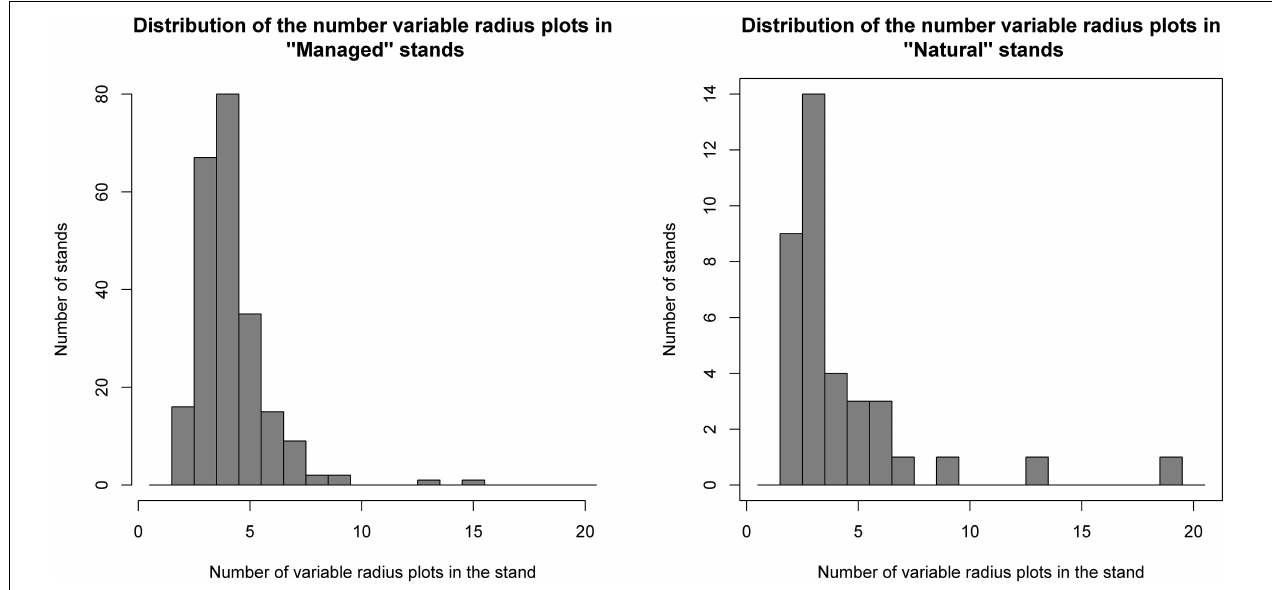
FIGURE 3 | Distribution of the number of VRP per sampled stand in natural and managed